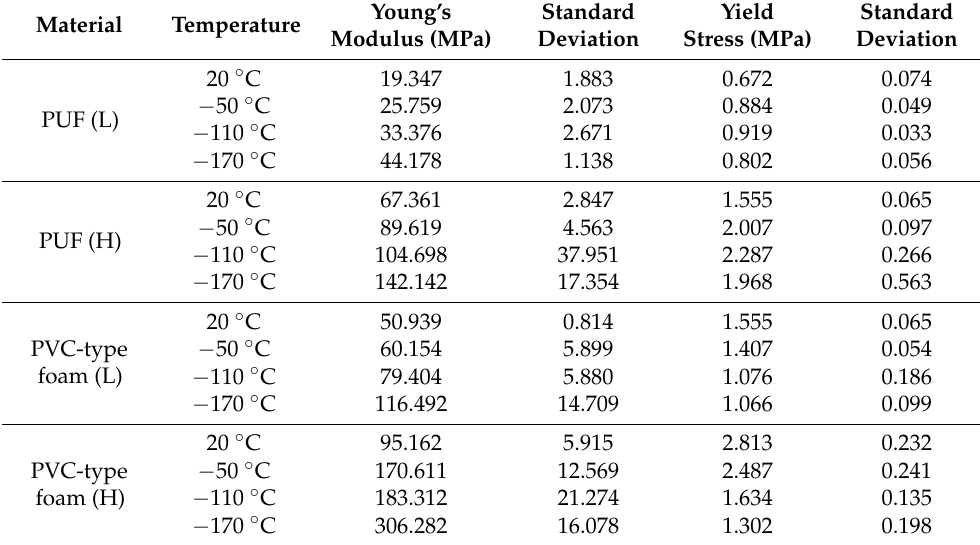
Table 5. Test results of tensile Young’s modulus and yield stress.